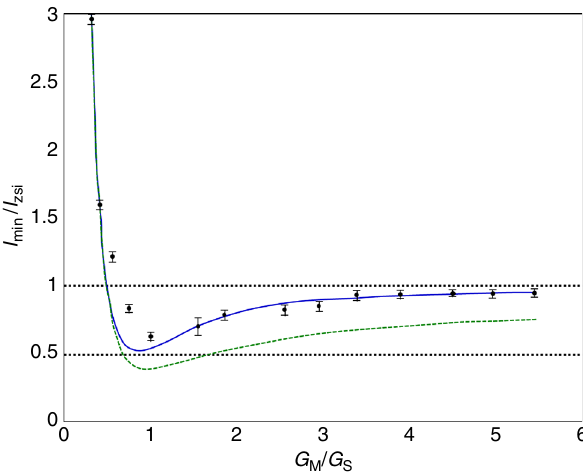
Fig. 7 Dependence of the squeezed fringe on the parametric gain. The squeezed quadrature can be directly obtained from the relative output of the minimum fringe when the measurement gain ( G M ) is large enough (relative to the squeezing gain — G S ) — the ratio between the output with input ( I min ) and the output with vacuum (blocked) input ( I zsi ). For increased measurement gain (but constant input squeezing), the relative parametric output should therefore converge to a constant level, directly indicating the absolute quadrature intensity. To observe this, we varied the pump intensity in the second (measurement) pass up to 5.5 times the intensity used for generating the broadband squeezing in the fi rst (generation) pass. constant level of ~5% below the vacuum level. When the measurement gain is reduced, the relative output decreases due to a quantum interference effect, reaching maximum visibility when the squeezing generation gain is . In this regime, the general measurement becomes indirect (although the squeezing effect is still directly evident), and a pair of measurements (amplifying one quadrature Below the level of identical gain, the observed output strongly rises over the vacuum level, obscuring the direct evidence of squeezing; however, the quadrature information can still be extracted (though with reduced accuracy) using the same pair of measurements. The solid (blue) curve indicates a numerical simulation of the relative output, assuming the measured pump pulse energy and FWM loss, and an estimated nonlinear coef fi cient, fi ber coupling ef fi ciency, and hyperbolic-secant pulse shape. For comparison, we included the simulated result for the relative output at the peak of the pulse (dashed